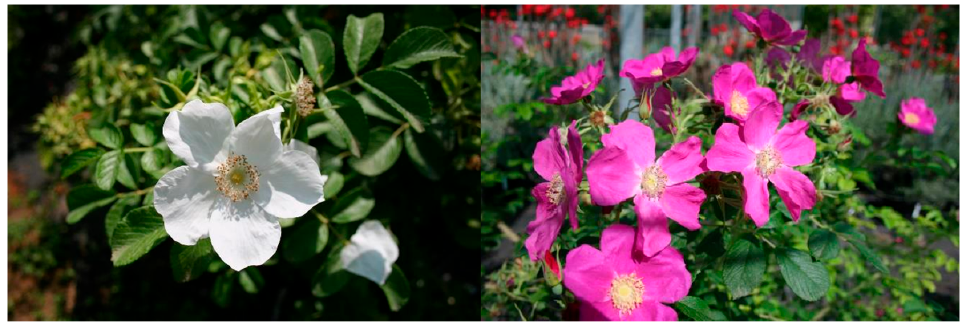
Figure 1. Flowers of Rosa rugosa cv. Alba ( left ) and cv. Rubra ( right ).